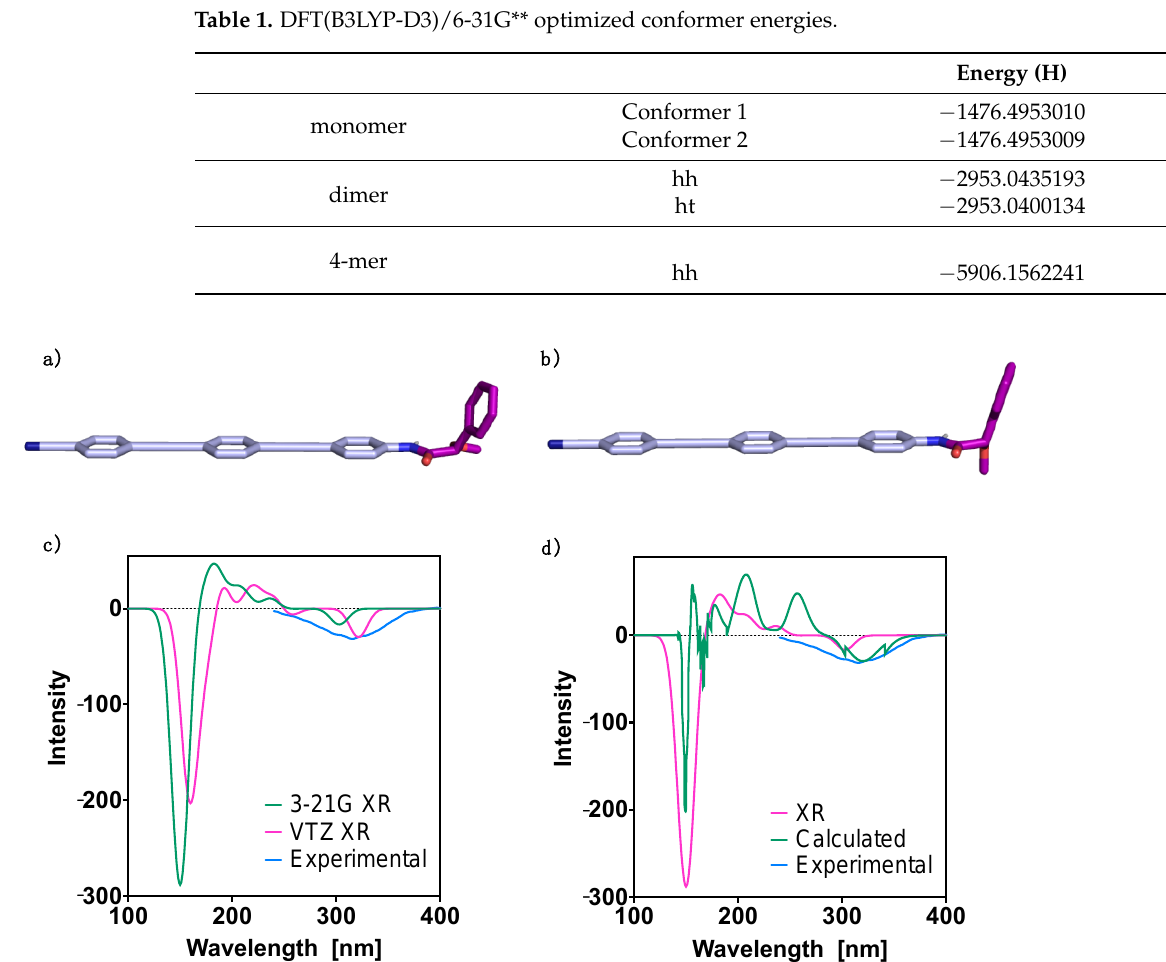
Figure 2. Oligo(phenyleneethynylene) (OPE) [( S )- 1 ] DFT(B3LYP-D3)/6–31G** optimized geometries for ( a ) the most stable conformer and ( b ) the second most stable conformer. TD-DFT (CAM-B3LYP) ECD spectra: ( c ) 3–21G and cc-pVTZ (VTZ) basis set results for the X-ray (XR) geometries; ( d ) 3–21G basis set results obtained for the X-ray (XR) and the DFT(B3LYP-D3)/6–31G** optimized geometries (the latter denoted Calculated). The corresponding experimental spectra are plotted for comparison. No correction factors are included in the theoretical wavelengths.